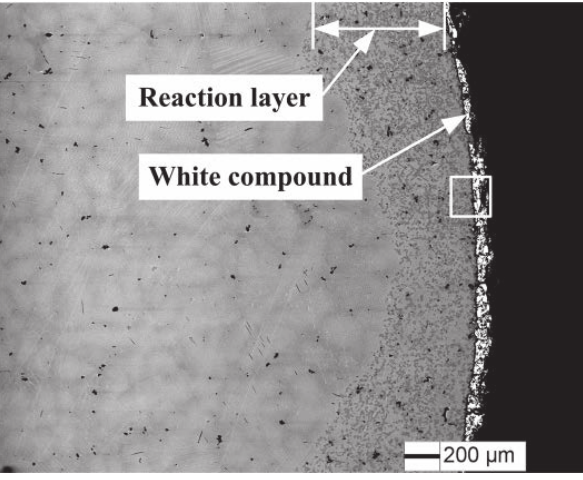
Fig. 4: (a) SEM micrograph, and SEM X-ray dot maps of (b) Ti, (c) Al and (d) O of the selected region in fig. 1, revealing the distribution of elements in